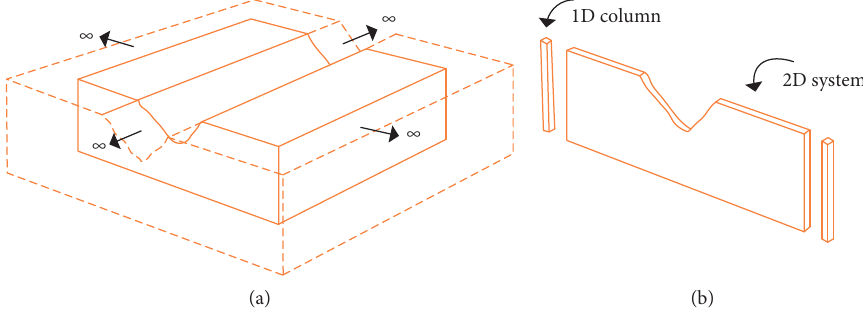
Figure 2: Computing effective earthquake forces with the direct FE method: (a) the 3D free-field system with uniform canyon cut in the foundation rock half-space; (b) the two-dimensional free-field system with corresponding 1D corner columns, reproduced from Lokke and Chopra